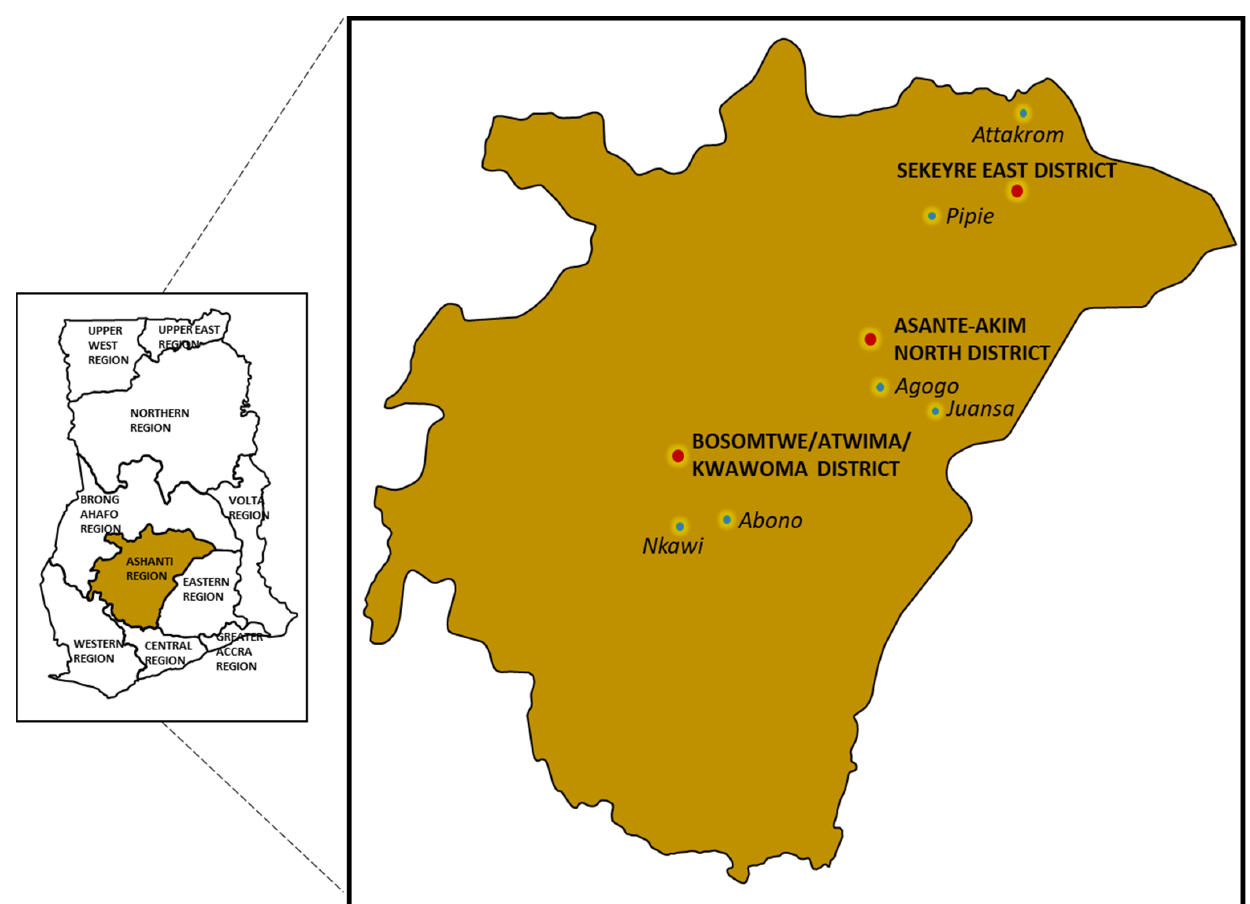
Figure 2. Map showing study districts and selected villages.